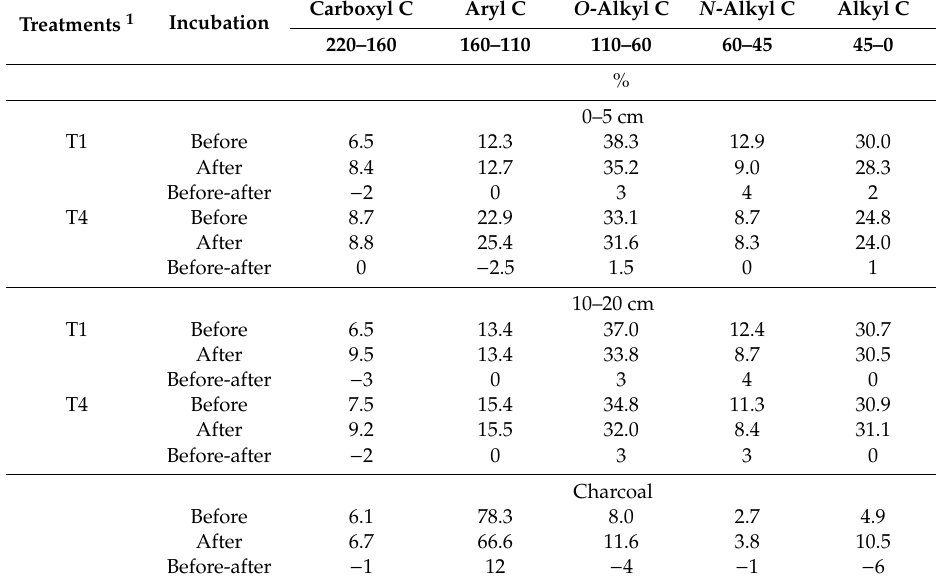
Table 3. Comparison of the relative intensity distribution (%) of Solid-State 13 C NMR spectra, before and after 165 days of incubation, of the charcoal and of the Cambisol samples collected at 0–5 and 10–20 cm depth after charcoal